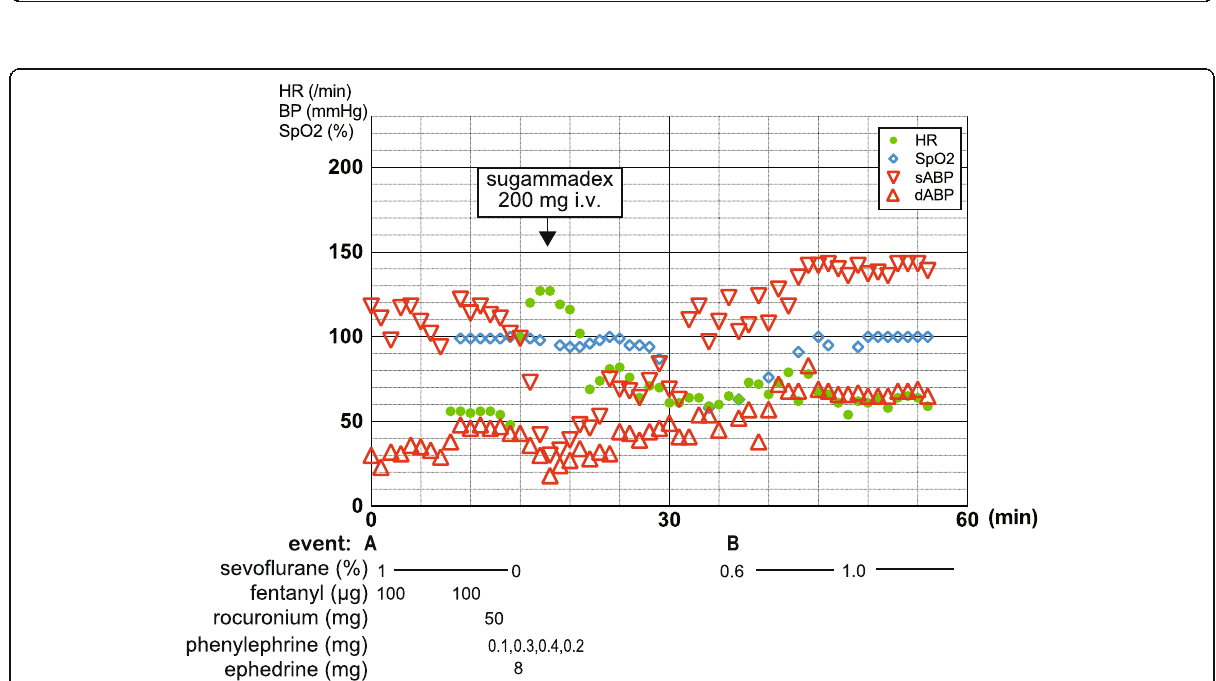
Fig. 3 Circulatory collapse following the administration of rocuronium for tracheostomy surgery, which was reversed by sugammadex. The systolic blood pressure decreased to 30 mmHg after the administration of rocuronium 50 mg, which recovered promptly by sugammadex 200 mg. a Start of anesthesia, ( b ) Restart of anesthesia. HR, heart rate; BP, blood pressure; SpO 2 , arterial oxygen saturation; s/dABP, systolic/diastolic blood pressure measured through the arterial